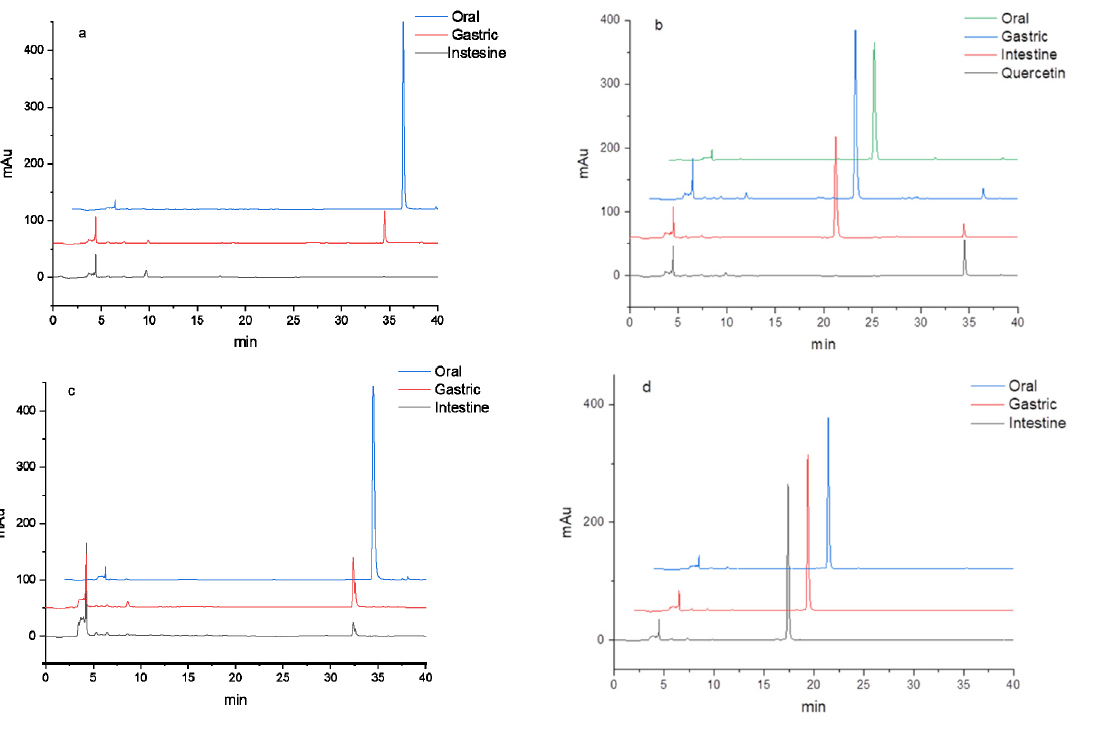
Figure 6. HPLC profiles of digested flavonoids: ( a ) quercetin, ( b ) isoquercitrin, ( c ) luteolin, and ( d ) orientin.